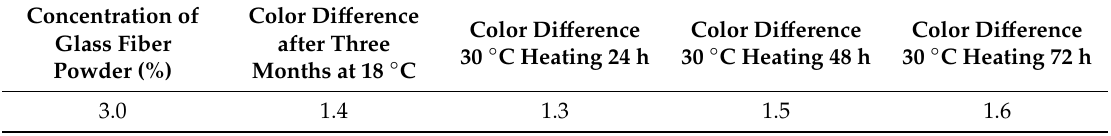
Table 10. E ff ect of time on the color di ff erence of waterborne coatings. Table 9. Effect of time on the color values of heat preservation waterborne coatings.